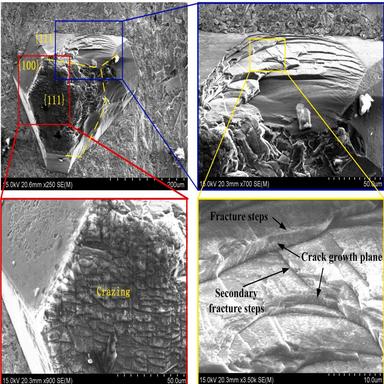
Wear morphology of DGs.